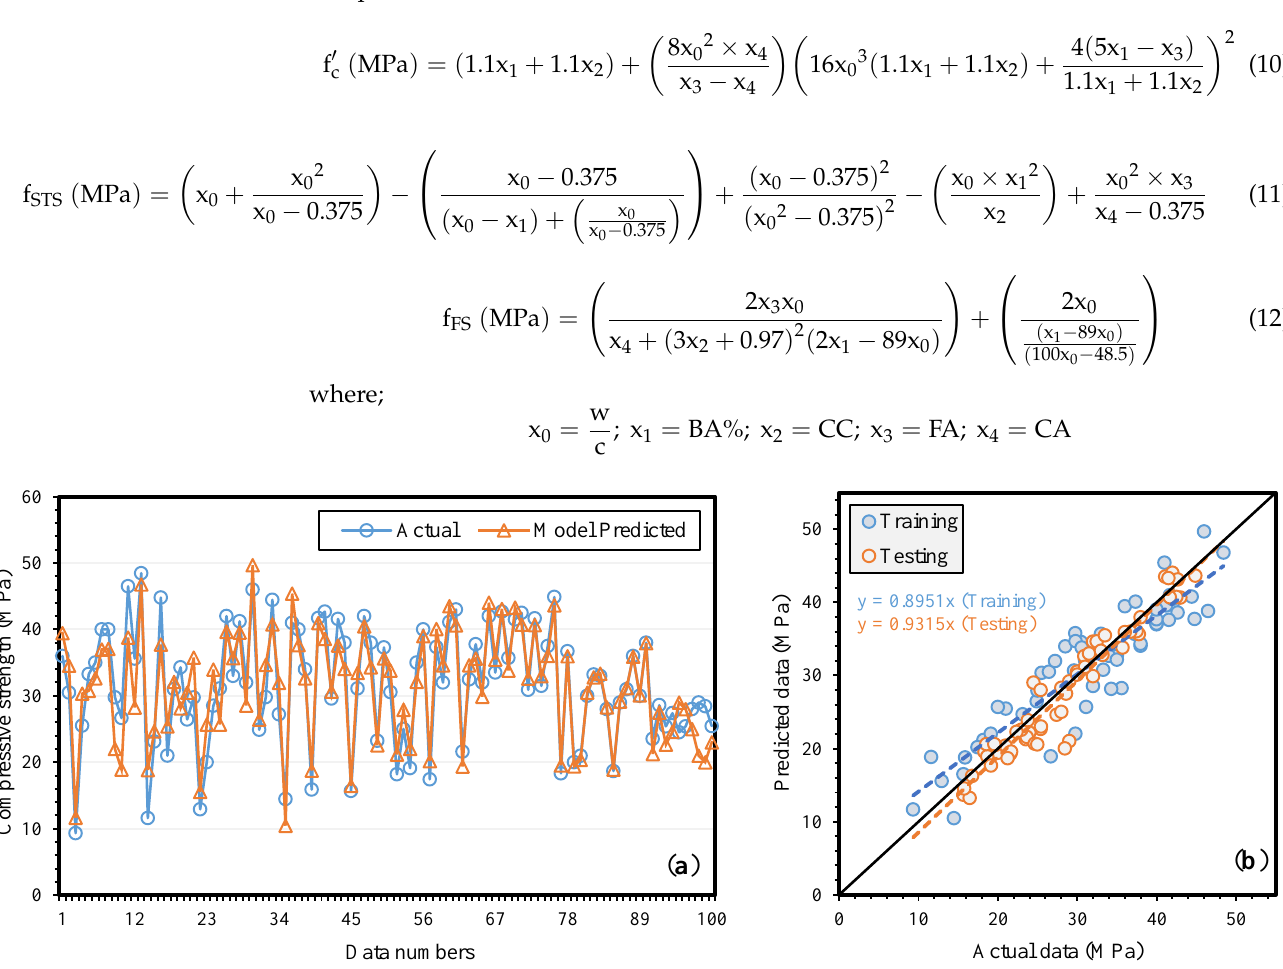
Figure 3. Comparison of actual and model predicted compressive strength ( a ) variation in data ( b ) scattered plot.